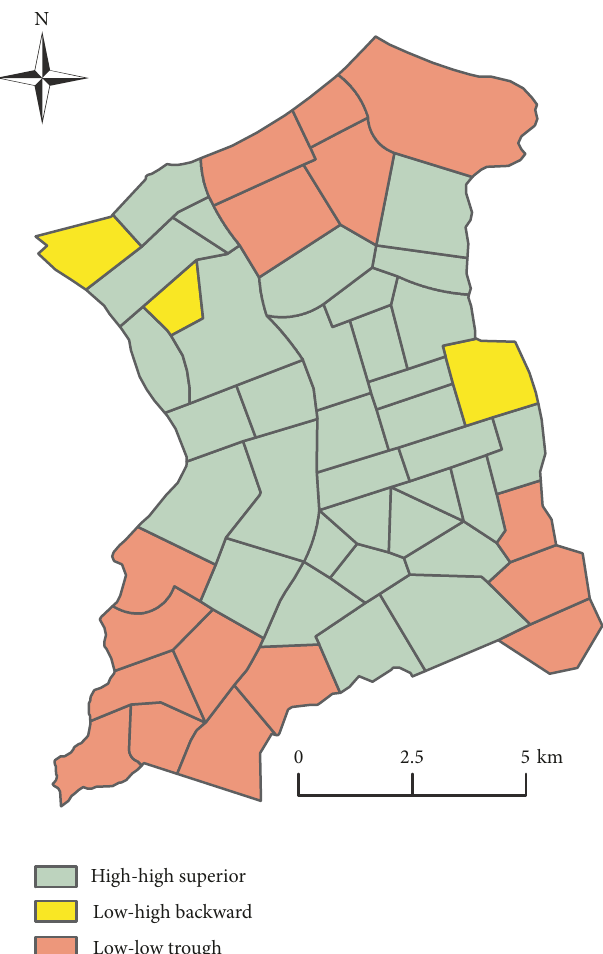
Figure 5: Spatial allocation pattern of public transportation resources in Chenggong New